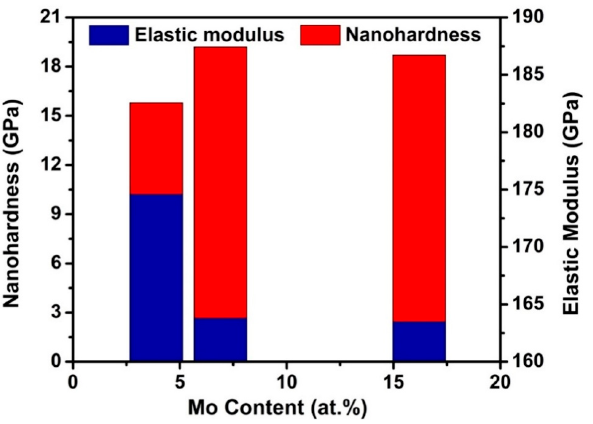
Figure 9. ( a ) Raman spectra of Mo-DLC coatings for different Mo contents ( b ) Gaussian fitting of Raman spectrum of 3.9 at.% Mo-DLC coating, and ( c ) corresponding I D /I G and FWHM of G peak evolution with different Mo concentrations in Mo-DLC coatings.